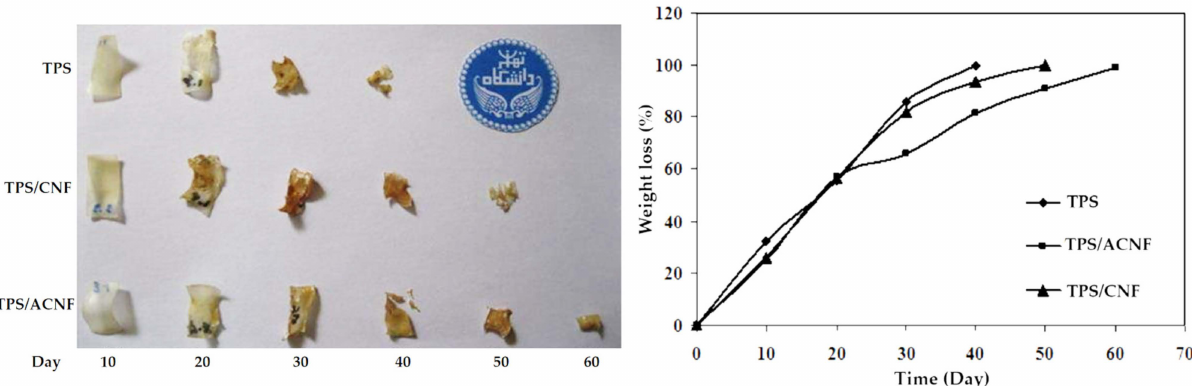
Figure 17. Visual and graphical fungal degradation of TPS and its nanocomposites. Reproduced with permission from Carbohydr. Polym. , 132 , Babee et al., Biodegradability and mechanical properties of reinforced starch nanocomposites using cellulose nanofibers, 1–8, 2015